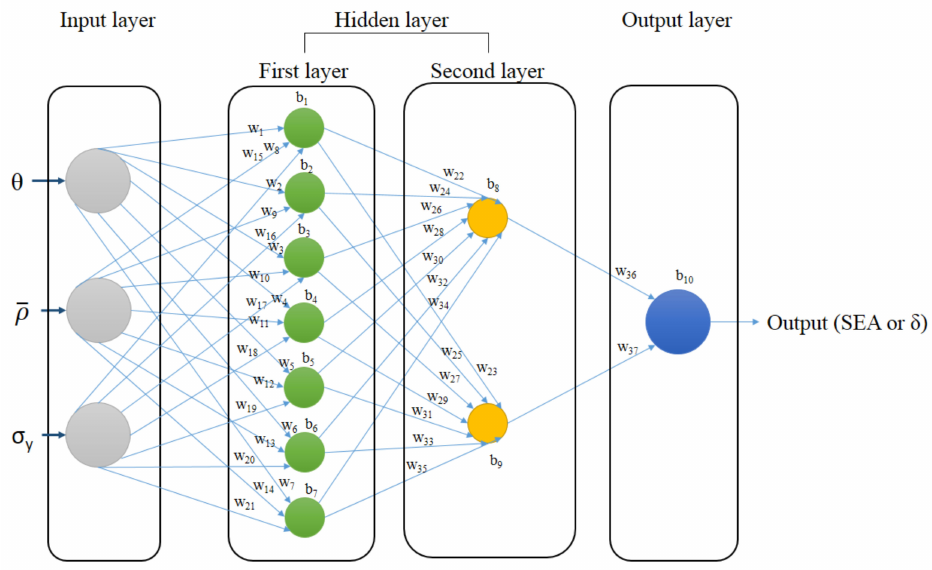
Figure 7. MLP network architecture